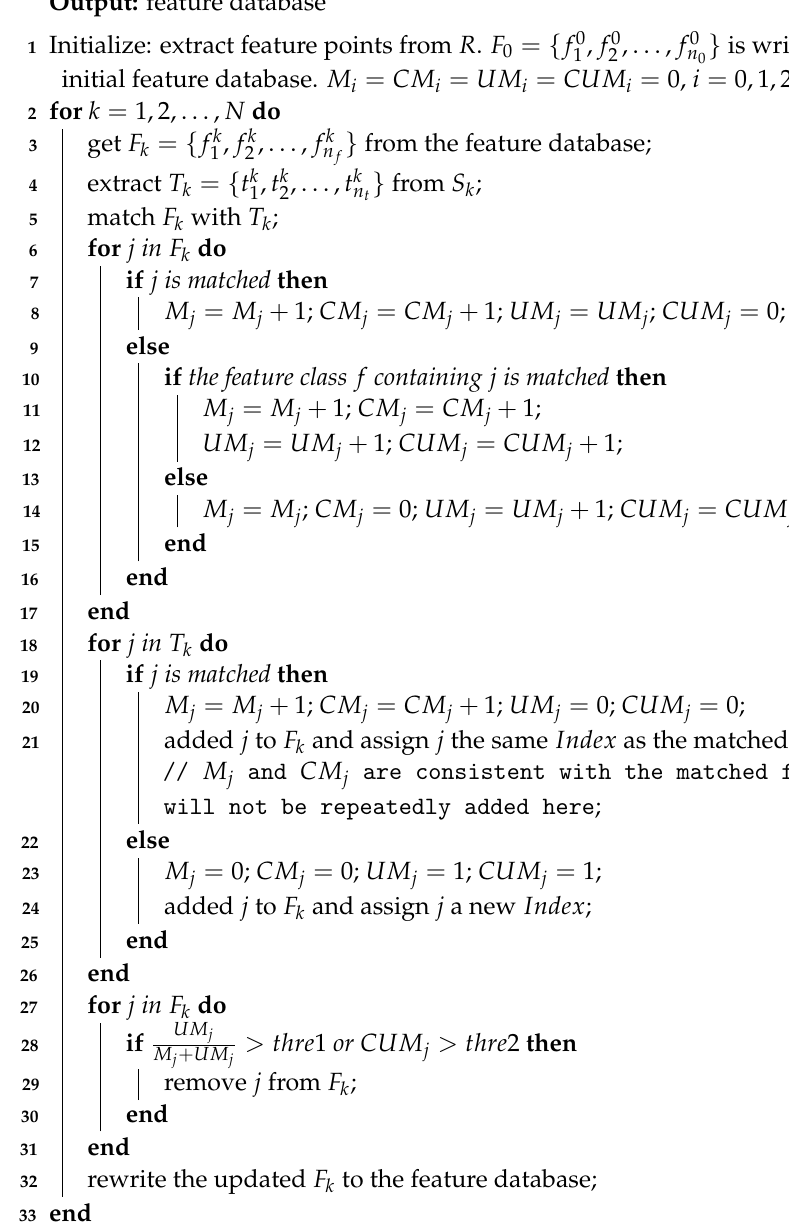
Algorithm 1: Feature Database